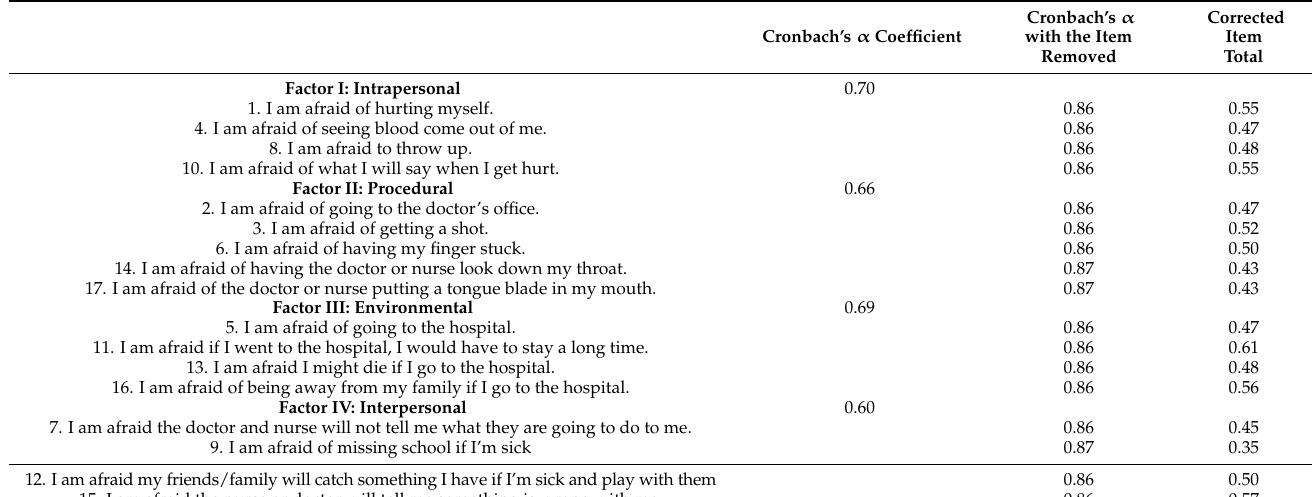
Table 2. The evaluation of the internal consistency of the